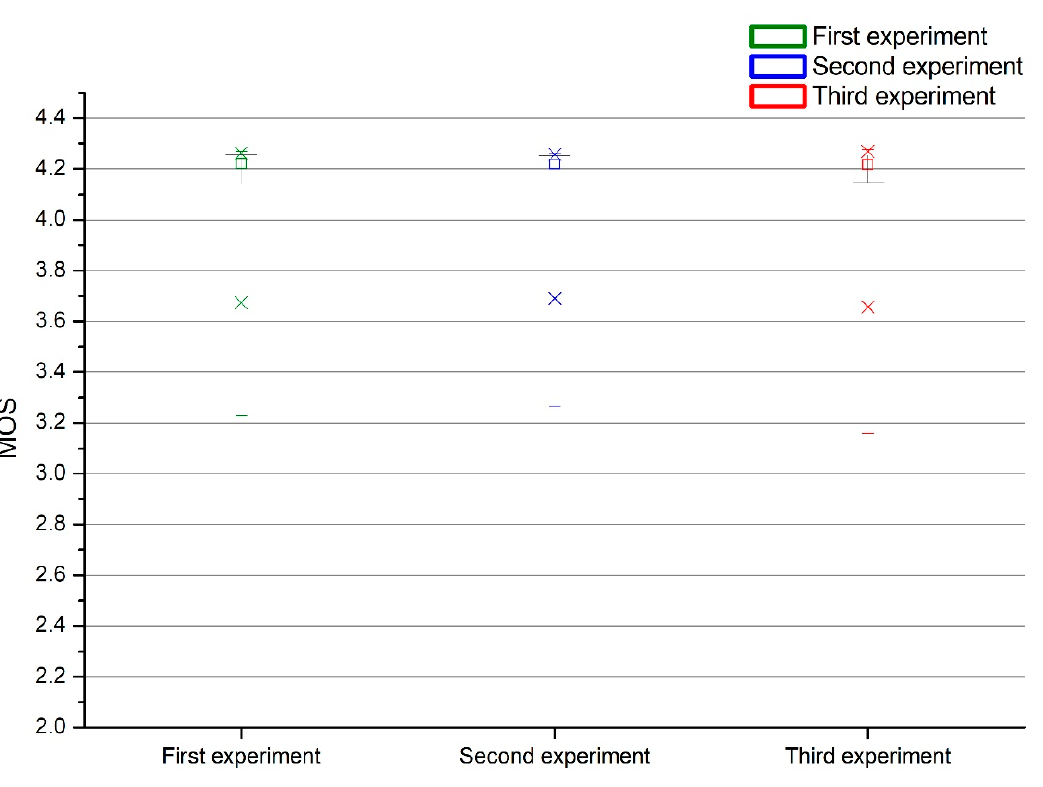
Figure 27. The confidence interval of MOS of the three experimental results for the proposed deep- learning-based handover mechanism.